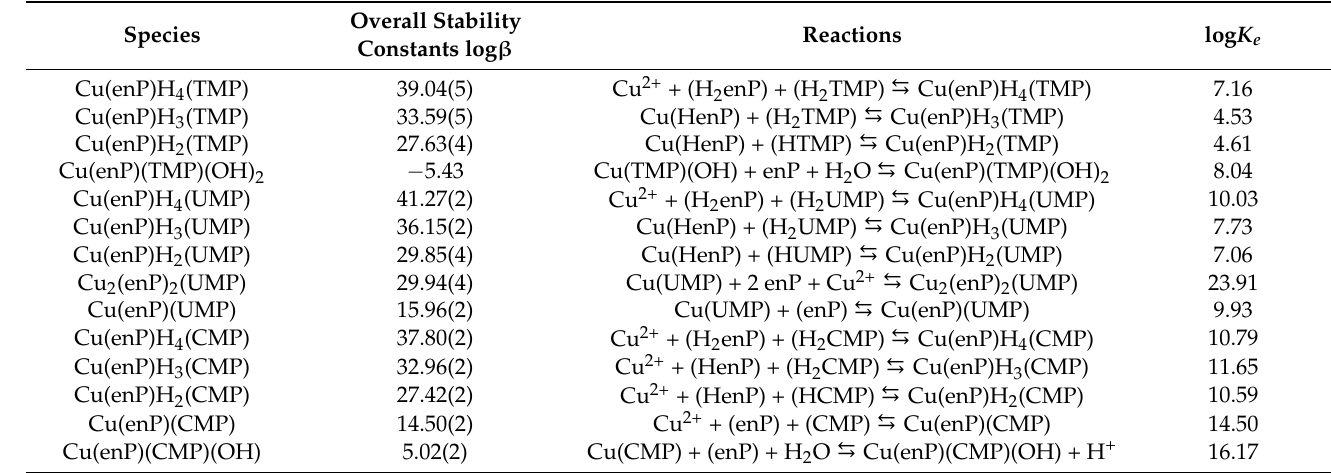
Table 4. Overall and stability constants as well as equilibrium constants of Cu(II) complexes in the Cu(II)/enP/NMP systems (standard deviation is given in parenthesis).